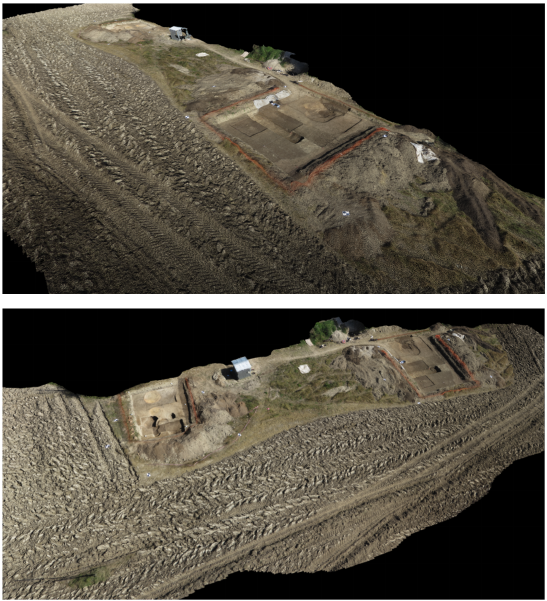
Figure 6: The area recorded during the excavation session in 2014. Fil- tered dense point cloud from UAV survey.